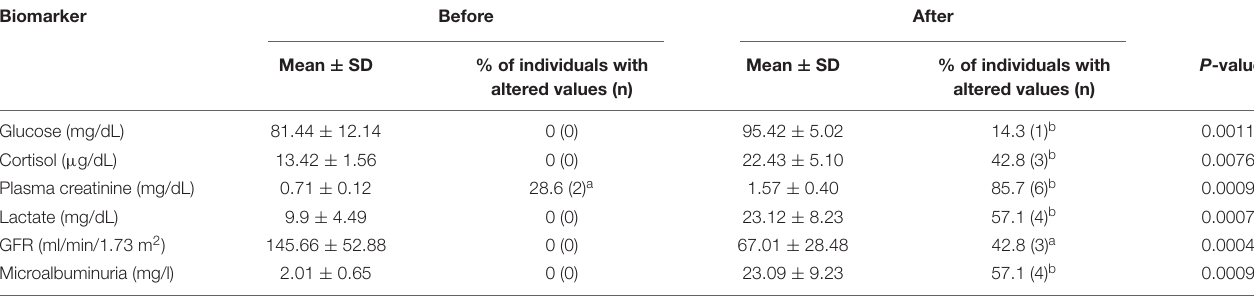
Microalbuminuria (mg/l)